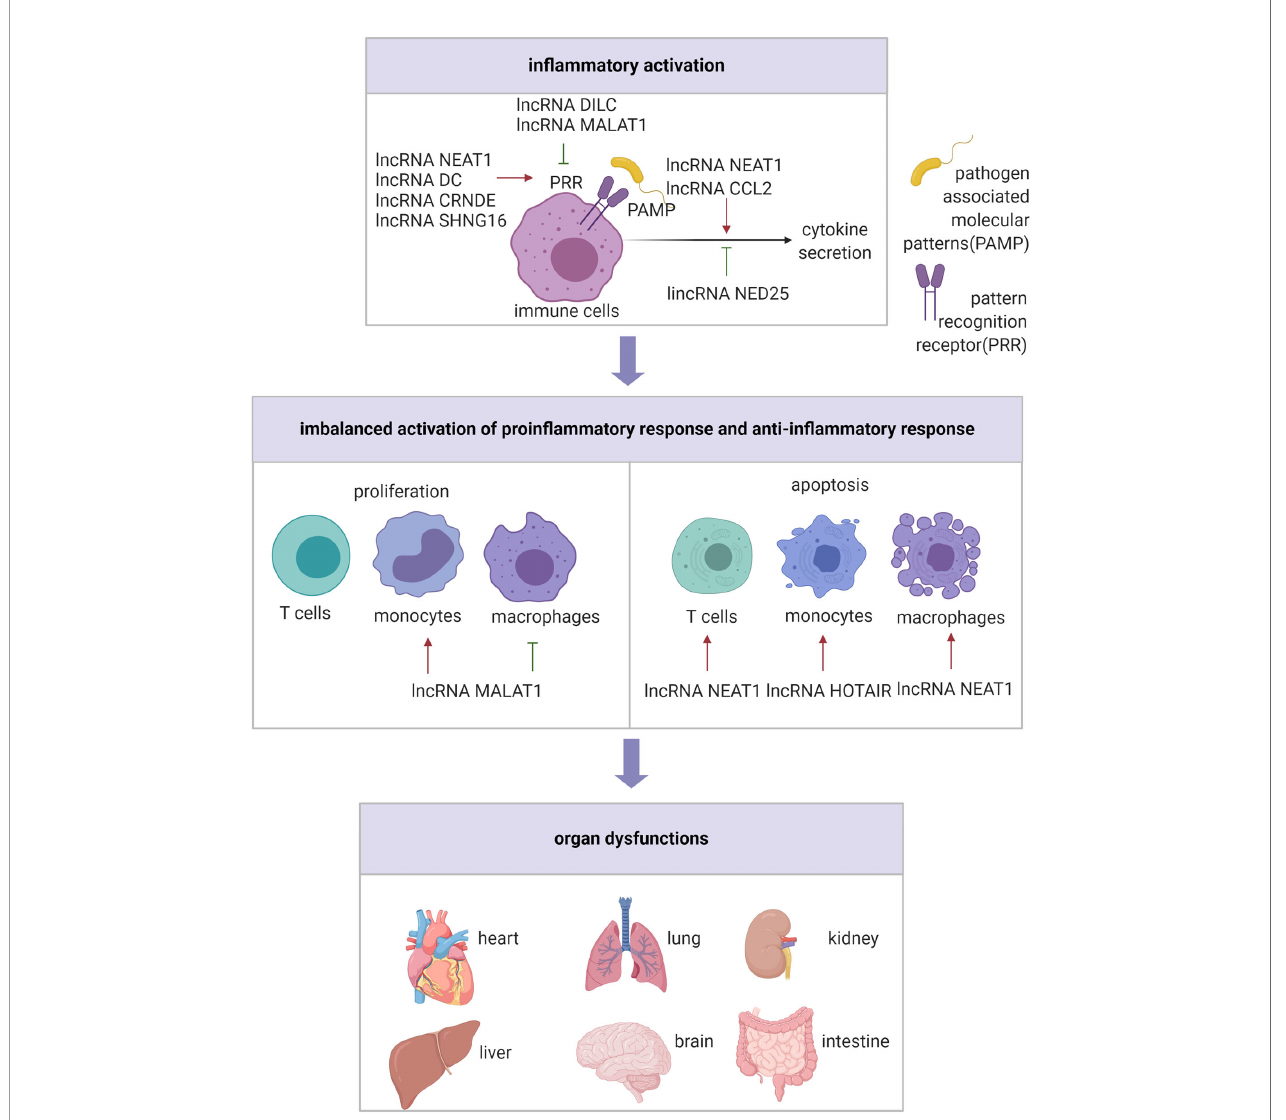
FIGURE 2 | The regulatory role of lncRNAs in in fl ammatory